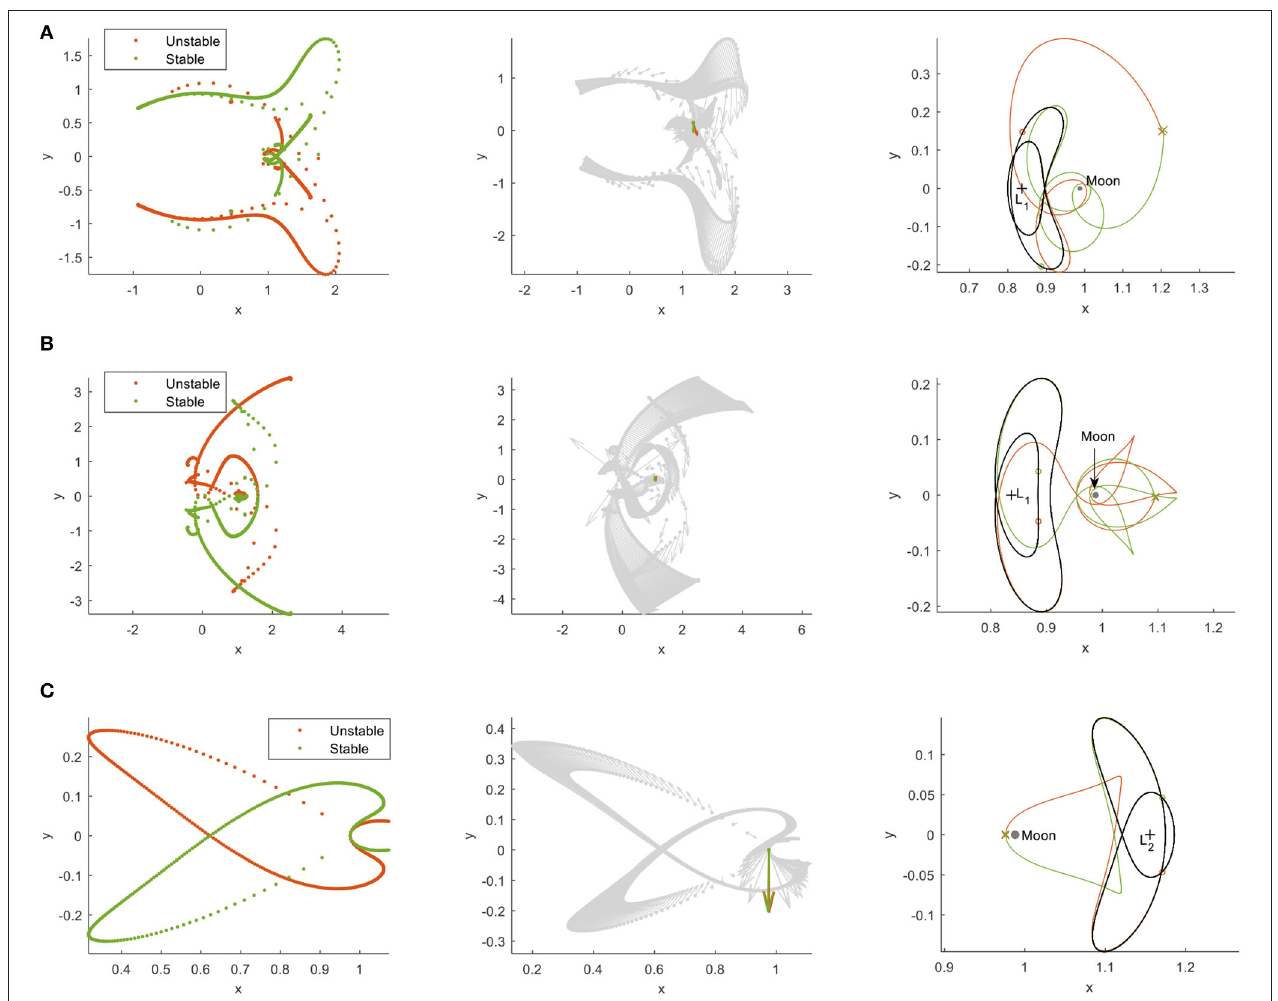
FIGURE 7 | Search for homoclinic connections for a fixed linkage time. (A) Transfer 1. (B) Transfer 2. (C) Transfer 3.